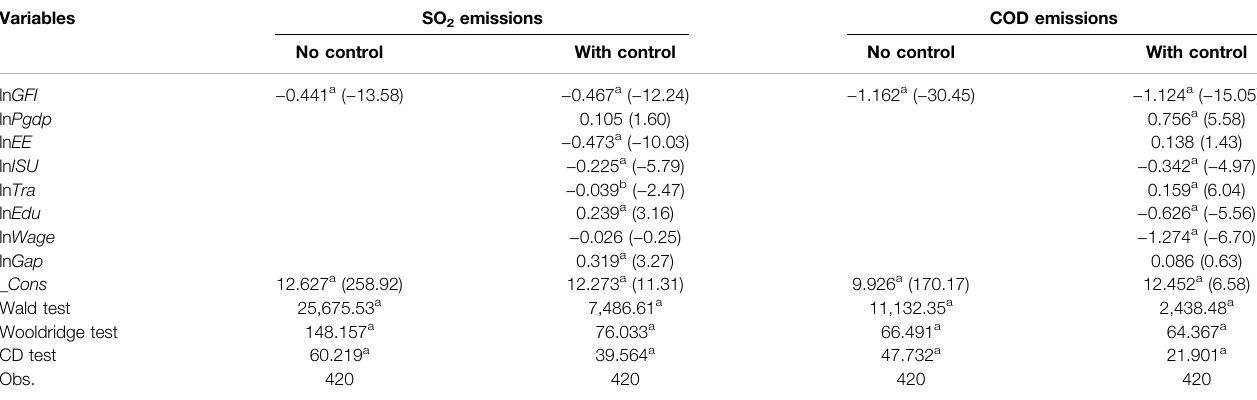
TABLE 4 | Robust results of alternative explained